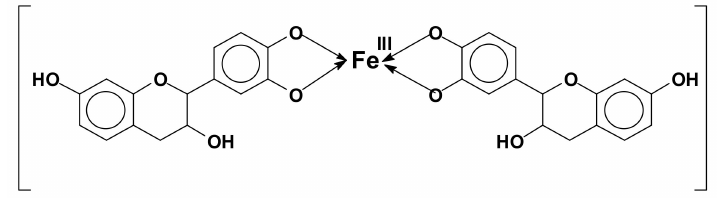
Figure 8. Example of orthodiphenol iron complex of a flavonoid